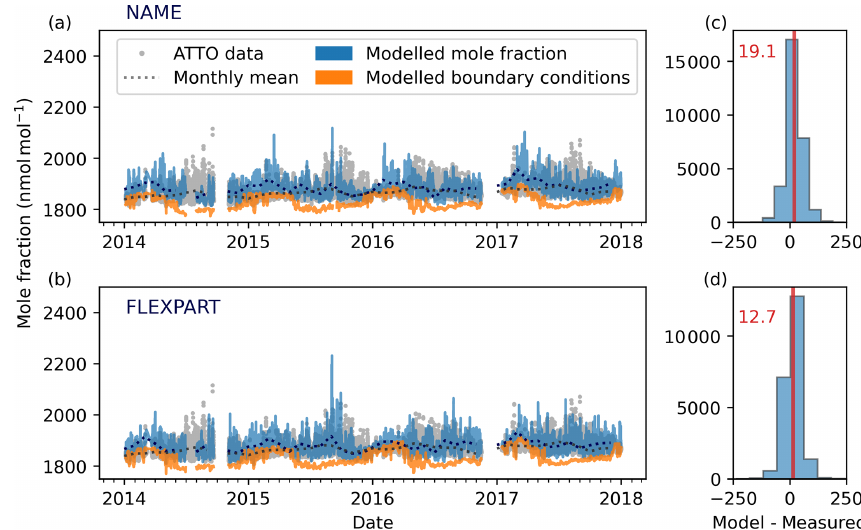
Figure A5. Comparison of modelled and measured mole fractions at ATTO with the same posterior emissions and boundary conditions convolved with sensitivity maps derived from two different models. (a) NAME model (main results) and (b) FLEXPART model where (c) – (d) shows histograms of the difference. Posterior emissions were derived from our inversion setup using both GOSAT and RPB data with an offset parameter between the two datasets allowed within the inversion.